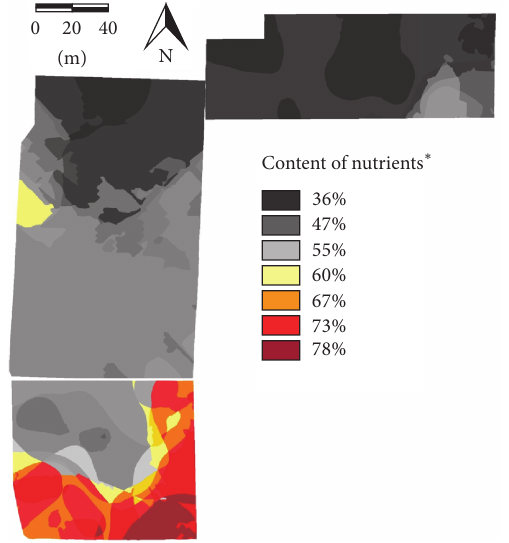
Figure 8: Spatial distribution of the content of nutrients (C, Ca, K, Mg, N, and P) in Ap horizon for the study area. ∗ C + Ca + K + Mg + N + P.